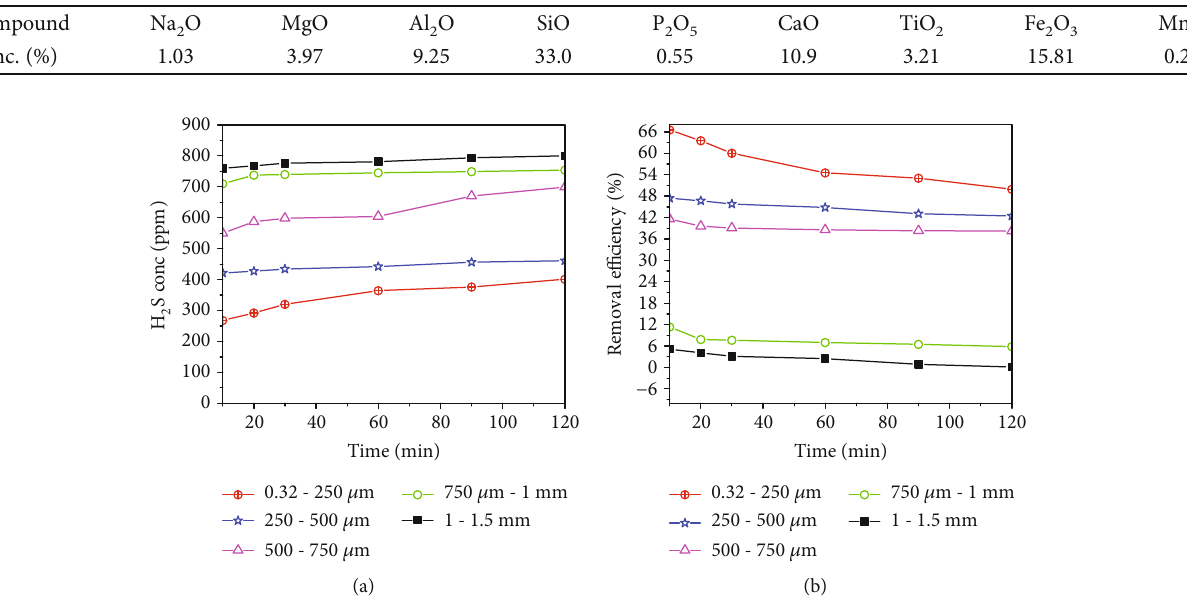
Figure 5: E ff ect of di ff erent particle sizes on the RR adsorption performance (a). H Test conditions: m = 0 : 1 g , FR = 0 : 06m 3 /h , C